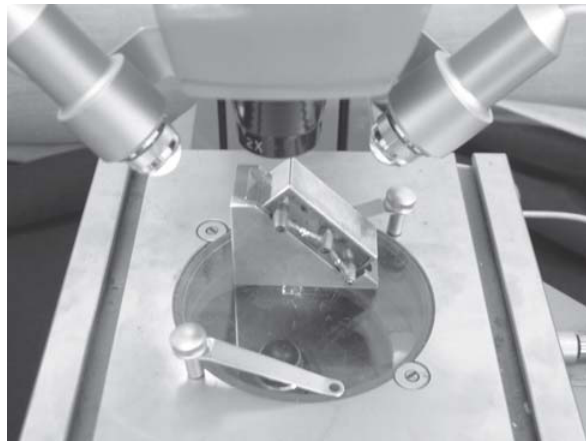
FIGURE 3A- Specimen positioned in the microscope for analysis